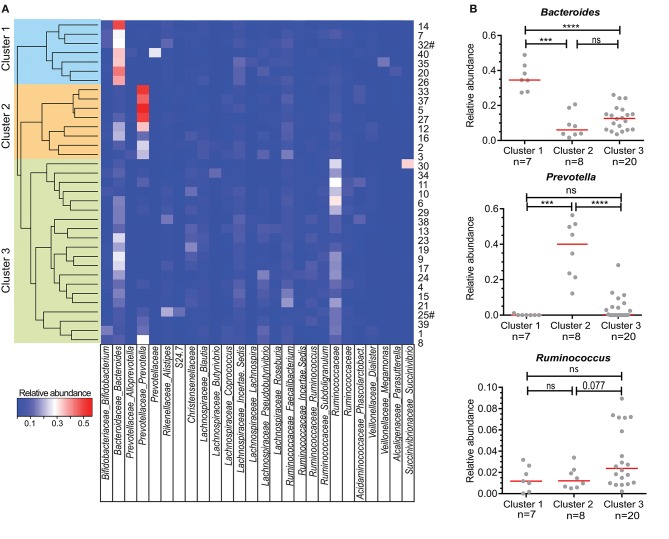
Clustering of individuals based on their microbiota composition. (A) Unsupervised hierarchical clustering based on Bray Curtis dissimilarity of 35 individuals using all detected bacterial genera (n = 228). Relative abundance of the most abundant genera are shown in the heatmap. When genus name was not assigned, the family name is given. A cluster of related microbiota profiles was determined as a cut-off value at height 0.7 of the dissimilarity index. Sample numbers given on the right # indicate vegetarian individuals. (B) Relative abundance of Bacteroides, Prevotella, and Ruminococcus for individuals within each of the three main clusters defined in A. Each dot represents one individual, red lines are median values. Statistics were calculated with Mann-Whitney U-test. ***P < 0.001; ****P < 0.0001.